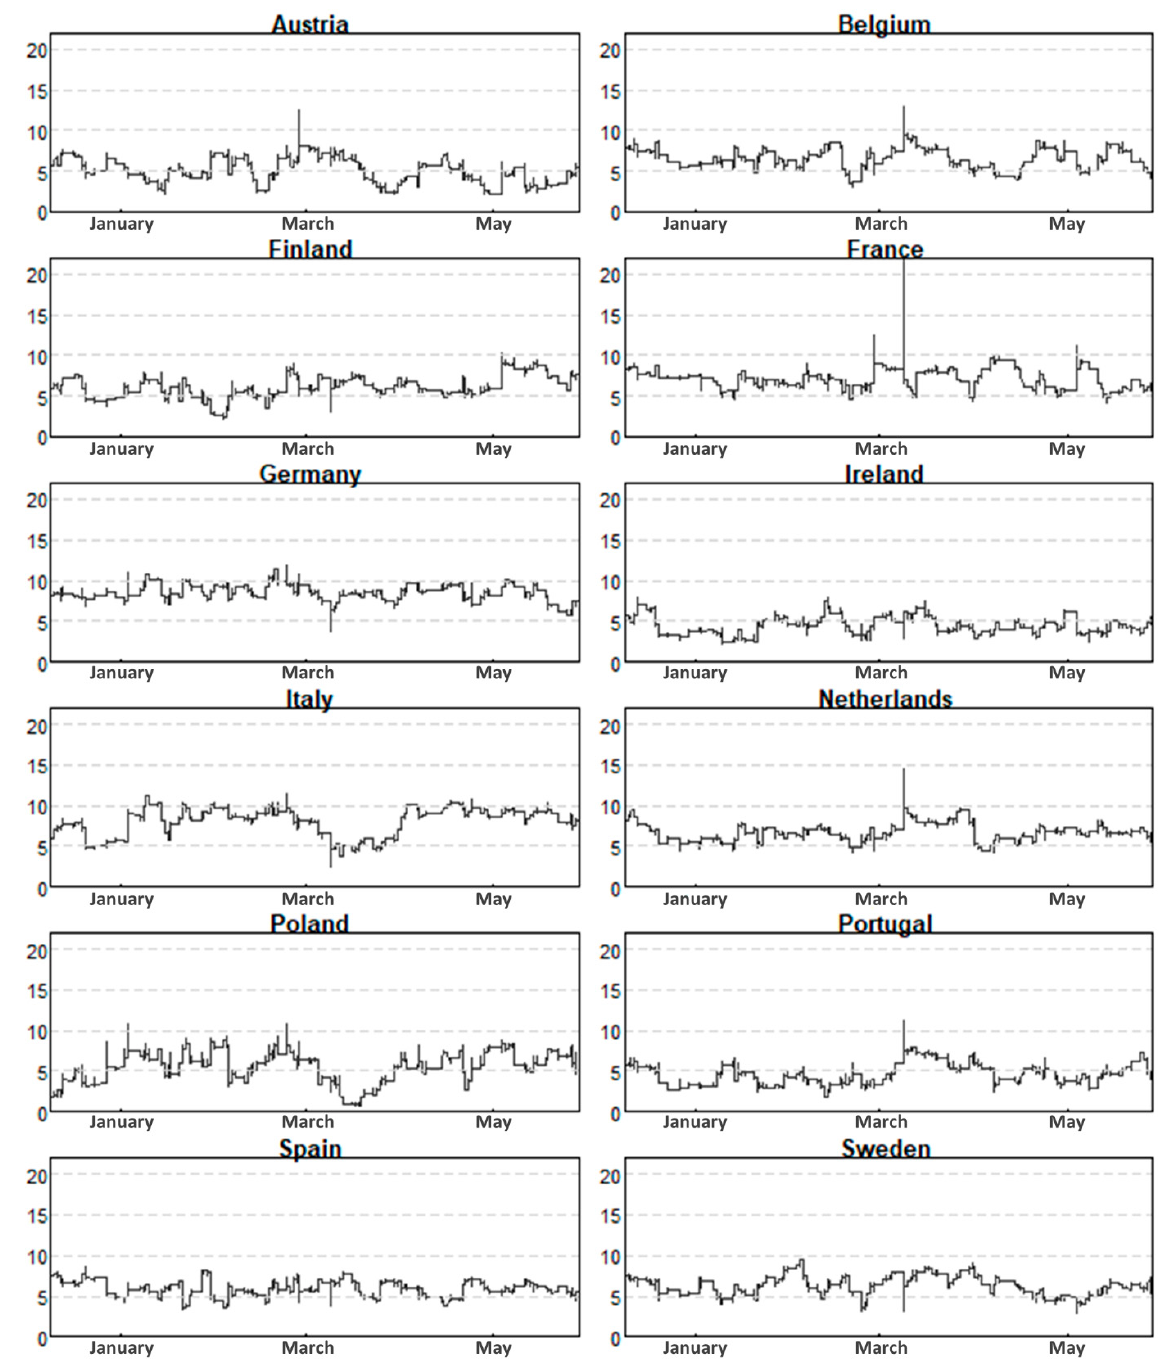
Figure 3. Intraday Directional volatility spillovers, TO all Stock Markets during COVID-19.